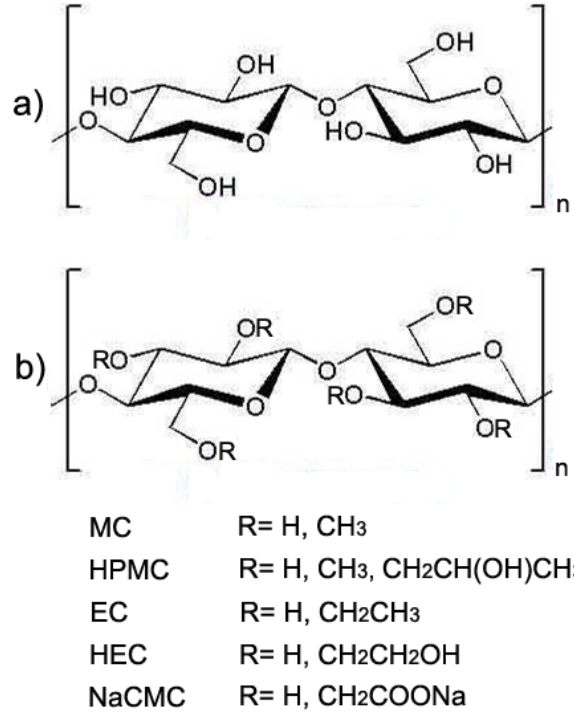
Figure 1. (a) Repeating unit of cellulose, also termed ‘cellubiose’. (b) Repeating unit of cellulose derivatives. The substituent group ‘R’ is indicated for methylcellulose (MC), hydroxylpropyl methylcellulose (HPMC), ethyl cellulose (EC), hydroxyethyl cellulose (HEC) and sodium carboxymethylcellulose